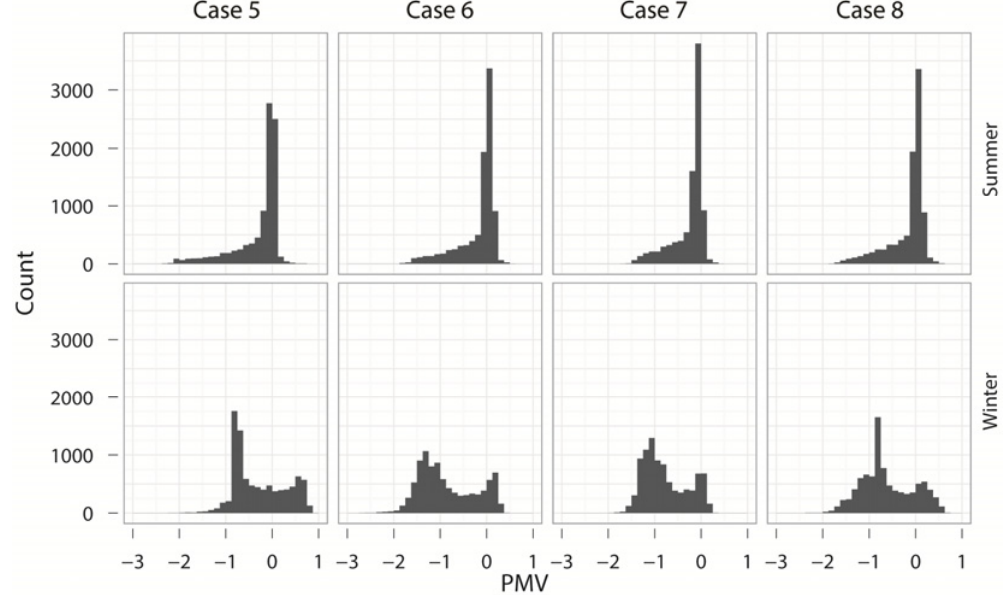
Figure 7. PMV histogram for Cases 5–8 divided in summer and